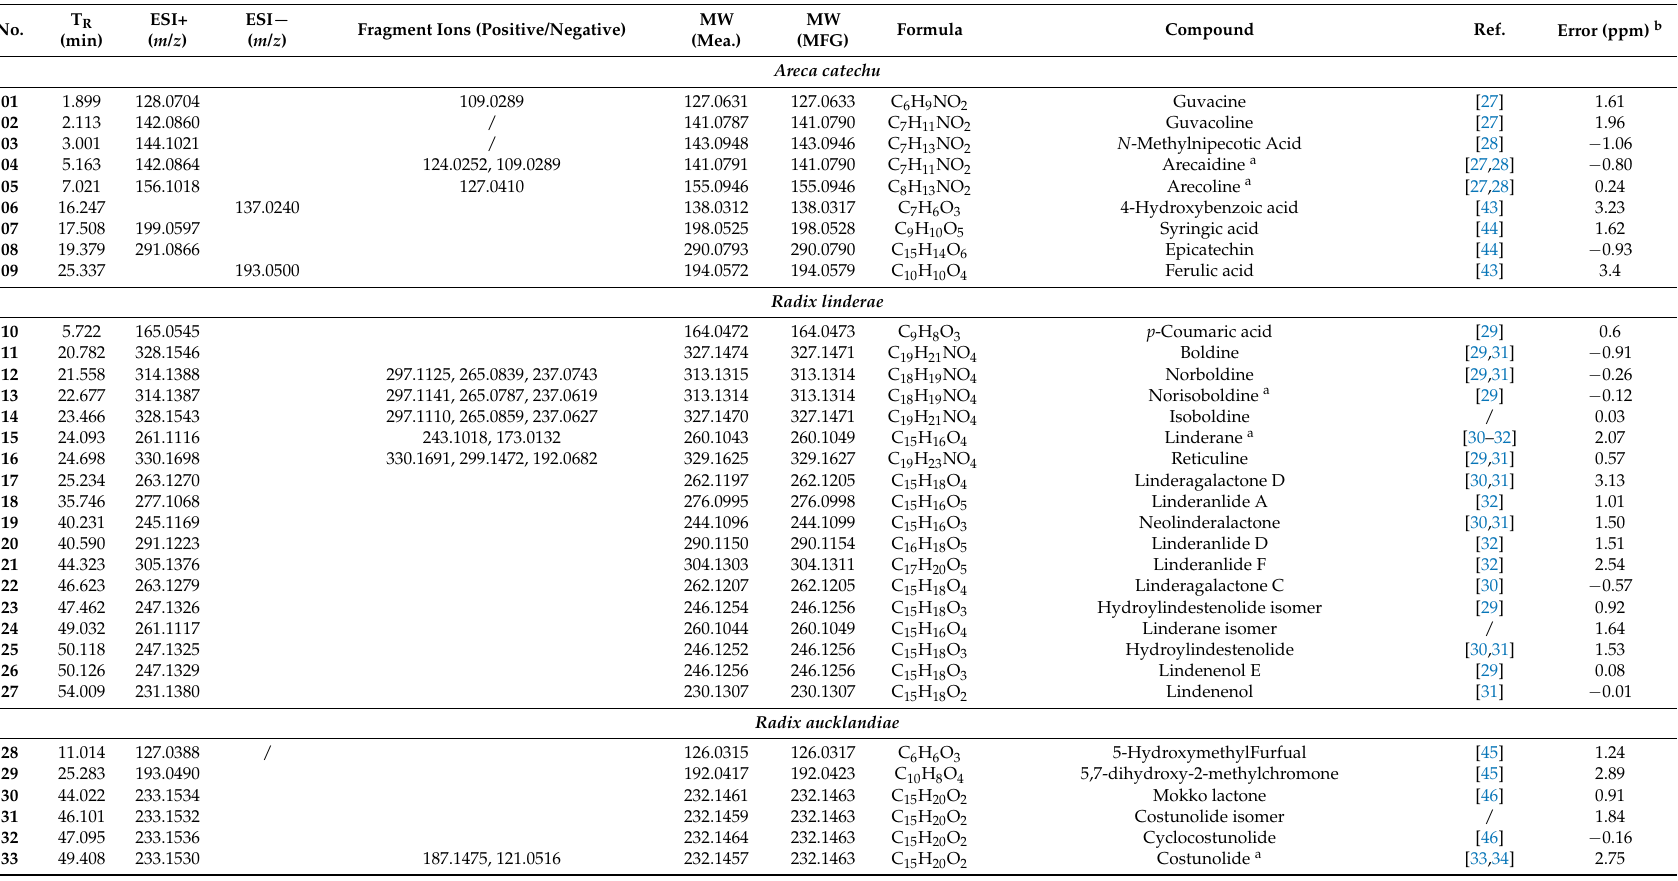
Table 1. Identification of constituents from Simo decoction (SMD) by liquid chromatography quadrupole time-of-flight mass spectrometry (LC-Q-TOF-MS) analysis in positive and negative ion